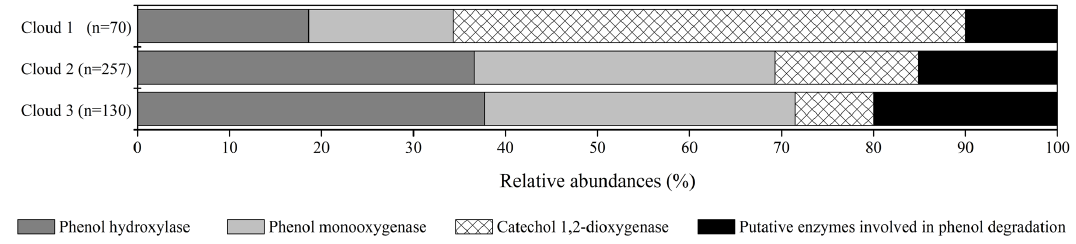
Figure 2. Relative abundance of transcripts in cloud waters encoding for enzymes involved in phenol degradation pathways. The absolute total number of hits for each sample is indicated ( n